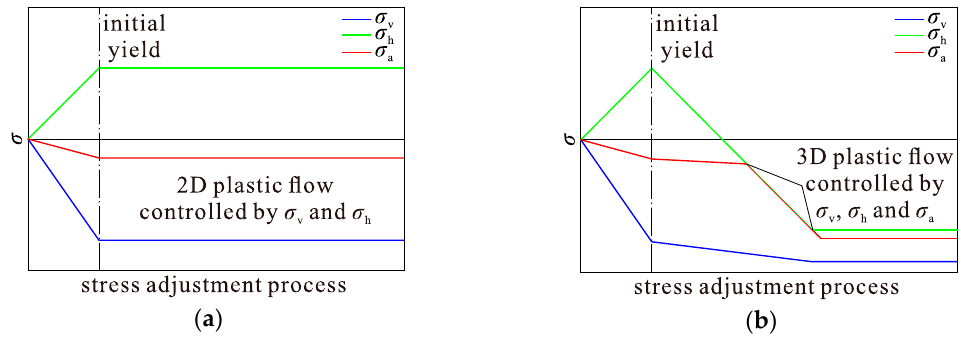
Figure 2. Stress adjustment and plastic flow of a microunit at the middle of the tunnel roof: ( a ) perfectly elastoplastic model and ( b ) considering strain softening.